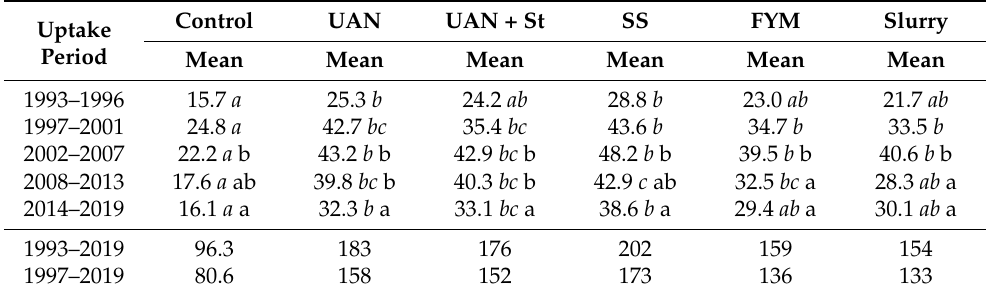
Table 6. Detailed sulfur plant uptake in the period during the experiment (kg S ha − 1 per period).